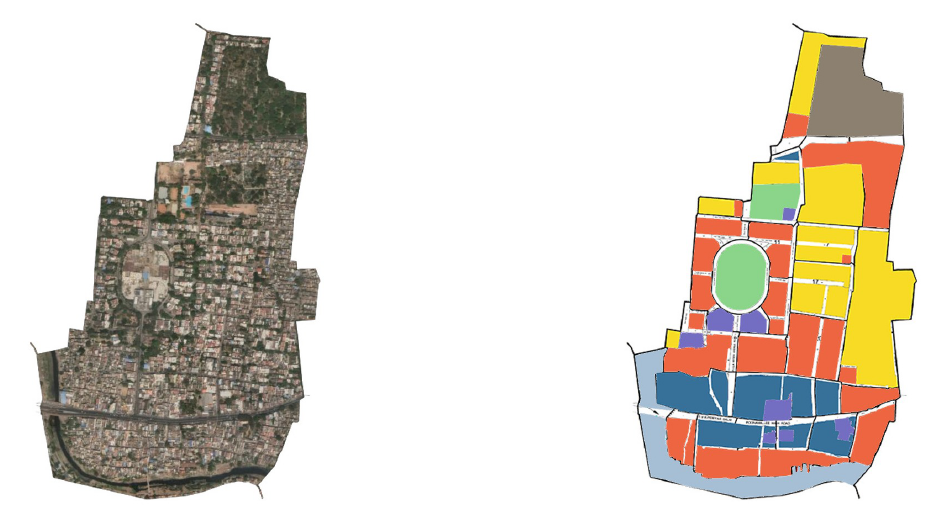
Figure 3. Satellite image and corresponding label—Chennai land use